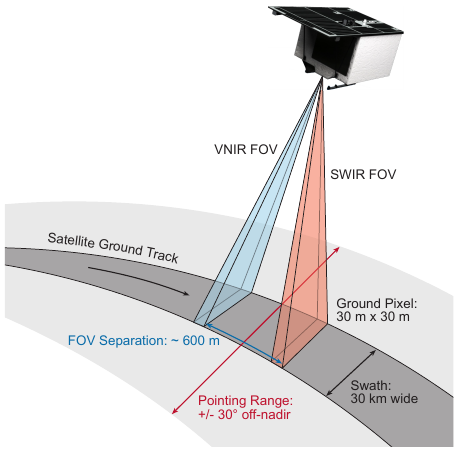
Figure 1. Representation of an EnMAP overpass featuring the dual-spectrometer instrument concept.